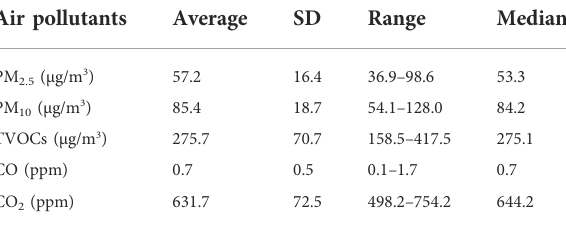
TABLE 4 Daily average children exposure to air pollutants in the monitored